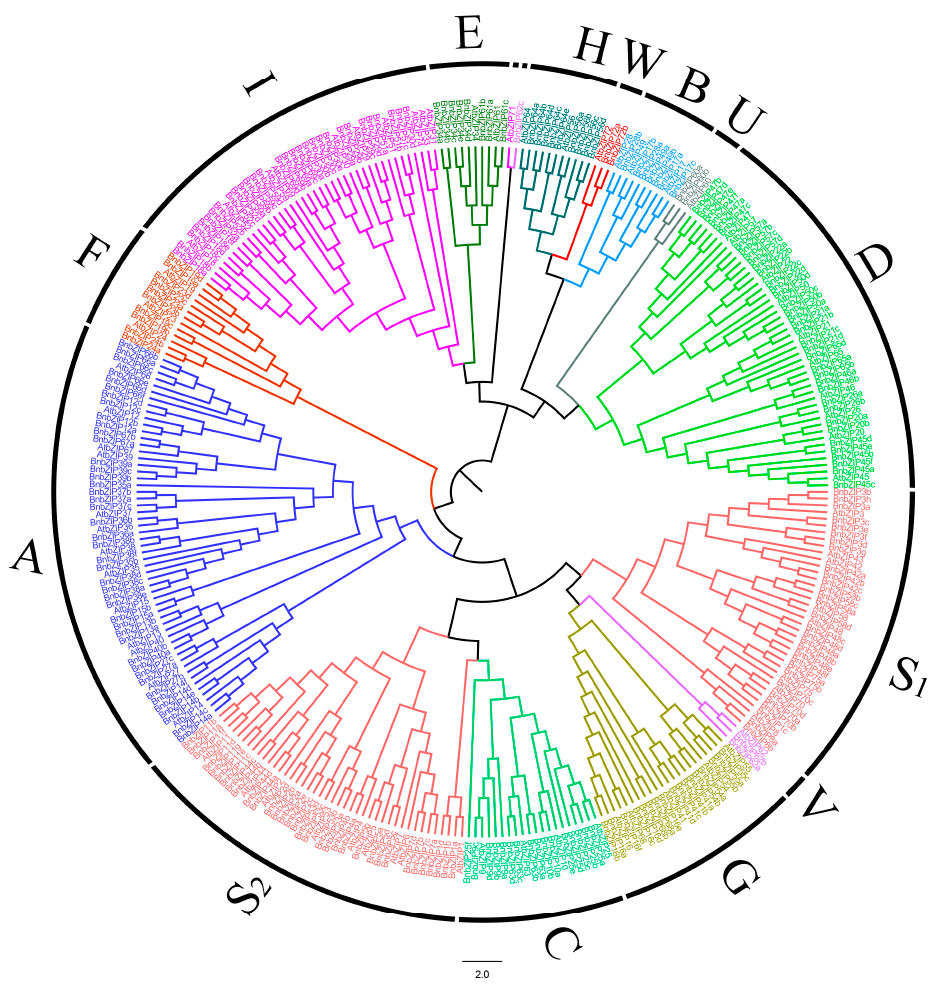
Figure 1. Phylogenetic analysis of the B. napus and Arabidopsis bZIP proteins. The protein sequences